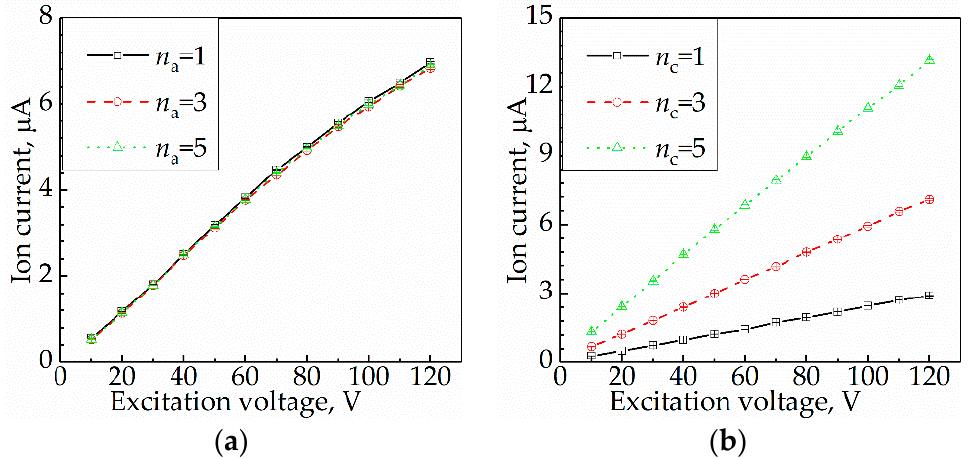
Δ = 5 mm: ( a ) platinum wire serving as an anode; ( b ) platinum U on I at Figure 4. Effect of U e on I at ∆ 1 = 5 mm: ( a ) platinum wire serving as an anode; ( b ) platinum wire Figure 4. Effect of e 1 serving as a wire serving as a cathode.